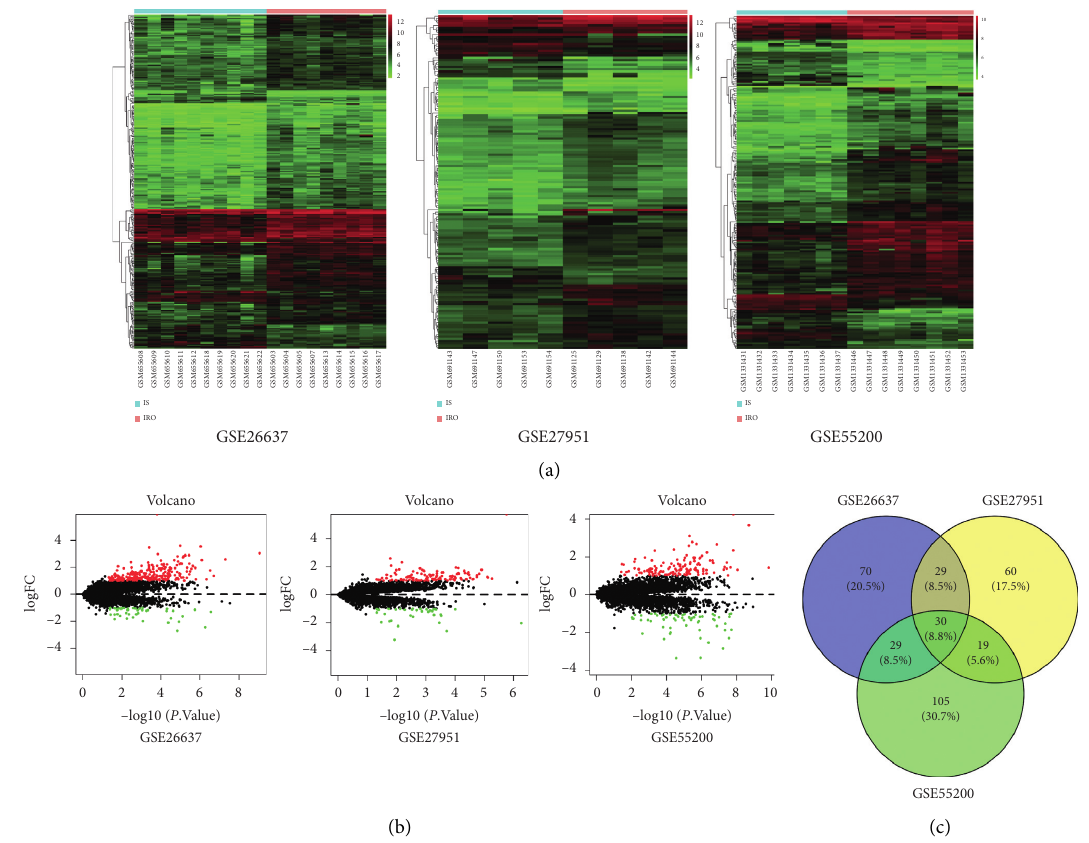
Figure 2: DEGs commonly expressed across three datasets. (a) The hierarchical clustering heatmap of upregulated and downregulated DEGs in the IRO group or IS group of each dataset. (b) The volcano plot shows upregulated genes (red points) and downregulated genes (green points) and genes without significance (black points). The differences threshold was set as |log2FC| > 1.0 and adjusted P value < 0.05. (c) The Venn diagram shows thirty DEGs commonly expressed across three datasets.